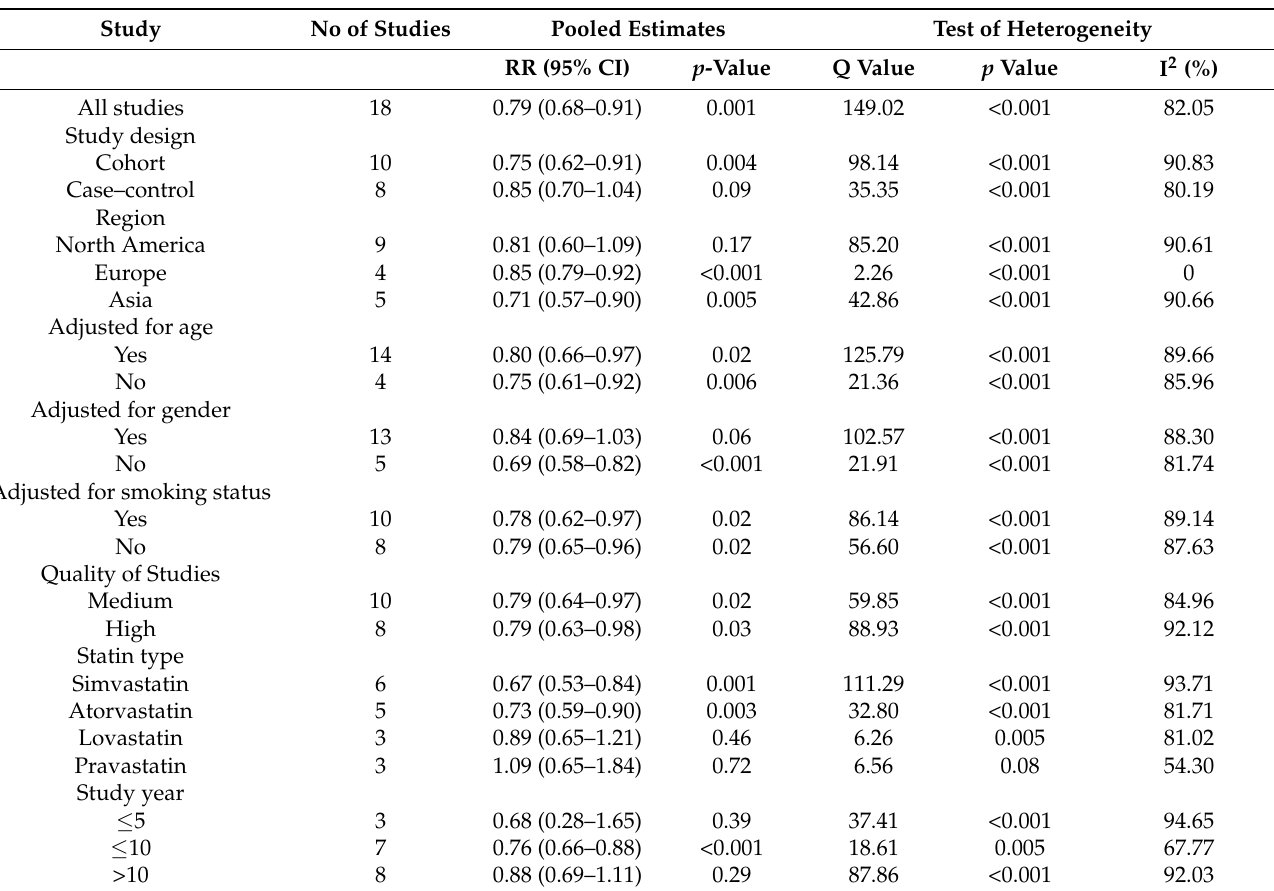
Table 2. Subgroup